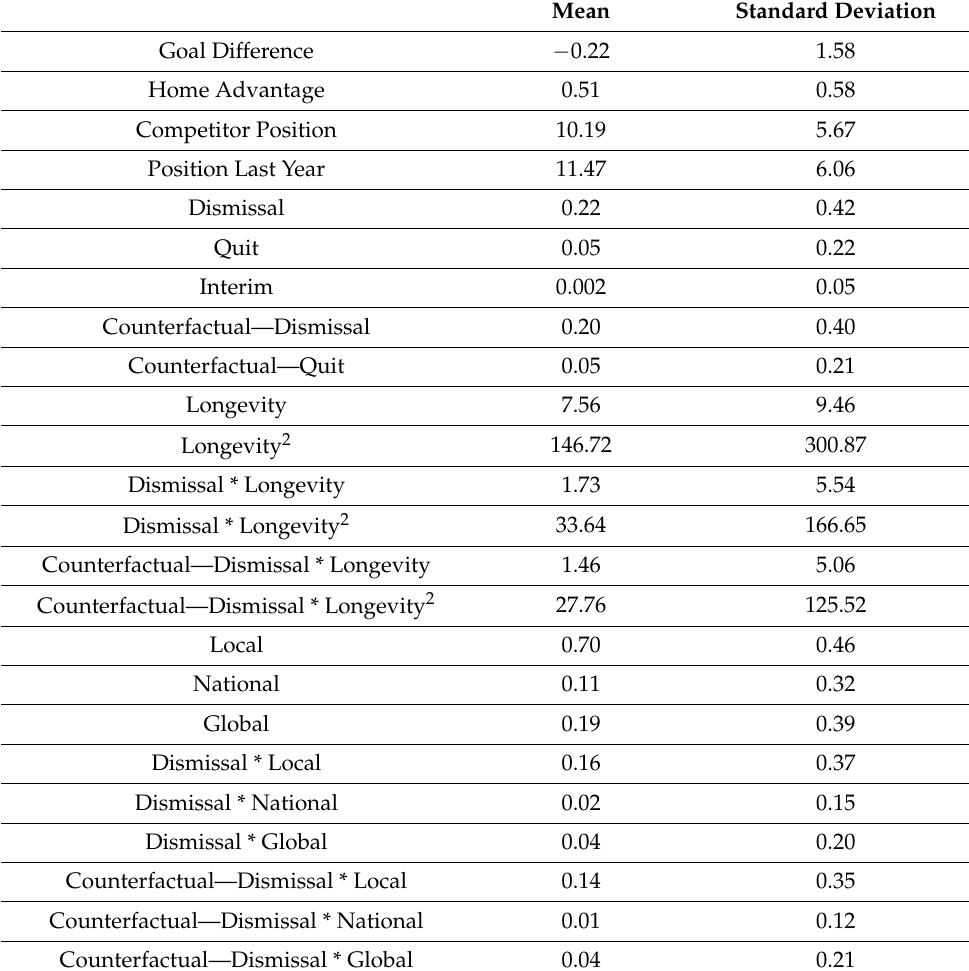
Table 1. Variables used in the analysis: means and standard deviations ( n =